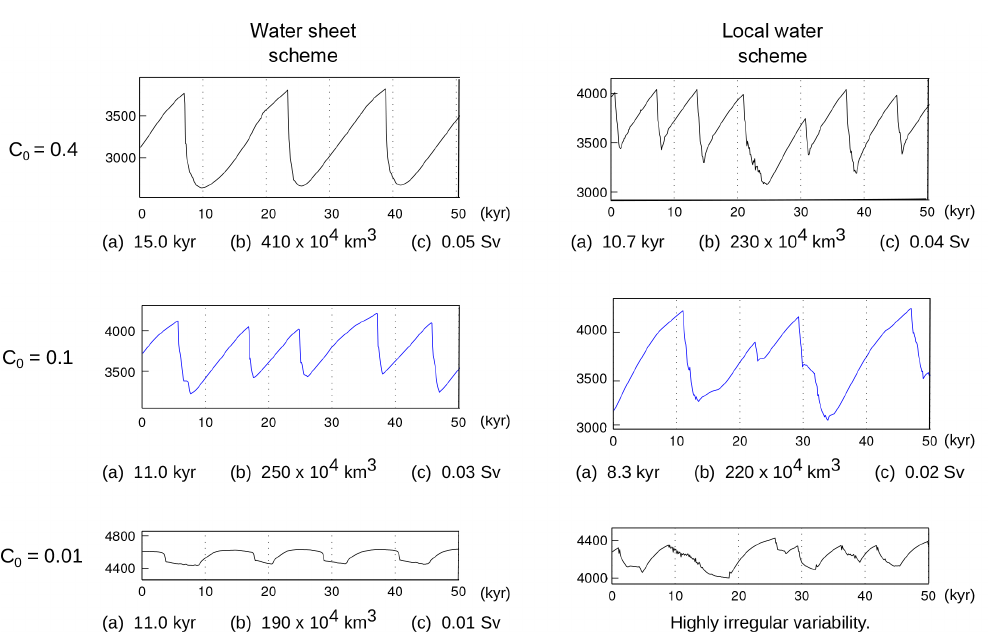
Figure 8. Summary of sensitivity to sliding parameter. We show the height of the ice sheet in the central Hudson Bay for three different values of the sliding parameter and for the two different water schemes. Example statistics for typical events, averaged over the full 100kyr are also shown; these are (a) the period, (b) the size and (c) the peak calving